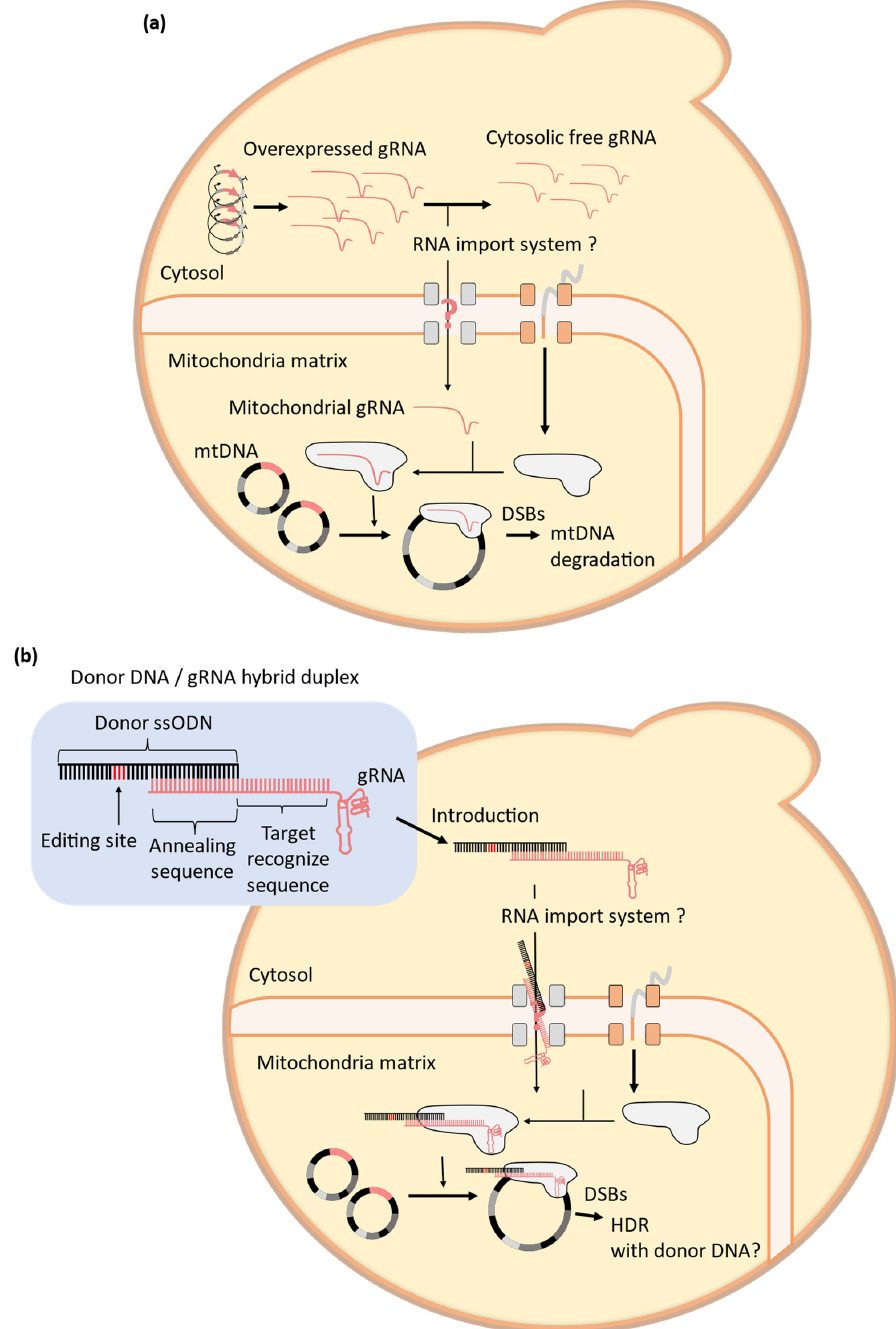
Figure 7. The potential of CRISPR-Cas9 systems targeting mitochondria in yeasts. ( a ) In yeasts, overexpression of mitochondrial targeting gRNA increases the rate of mtDNA degradation induced by the transport of Cas9 to mitochondria. Thus, the native mechanism of RNA transportation may also be applied to gRNAs in yeasts, and gRNA transportation could be used to recruit Cas9 to specific mtDNA regions and induce DSBs there. ( b ) The CRISPR-Cas9 system in yeasts can use a donor DNA / gRNA hybrid duplex, which may transport donor DNA components to mitochondria via the gRNA portion of the hybrid duplex.